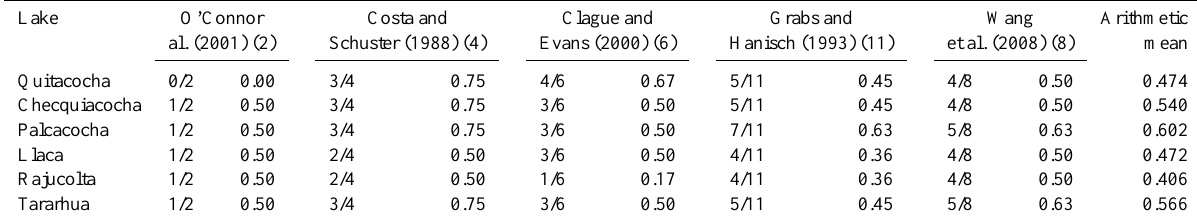
Table 9. The results of the five qualitative methods investigated in this study (total number of investigated parameters in brackets). Lake O’Connor